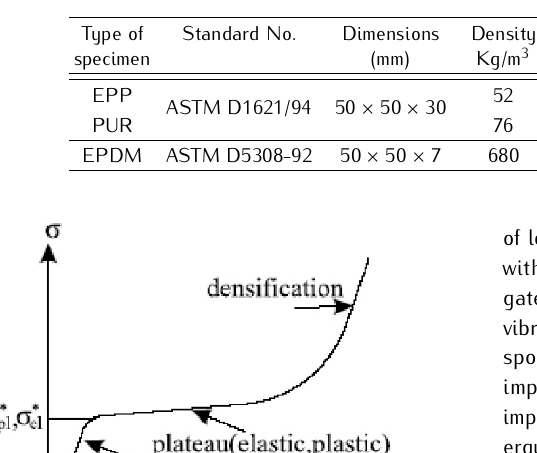
Table 1. Description of the specimen properties and test procedures.